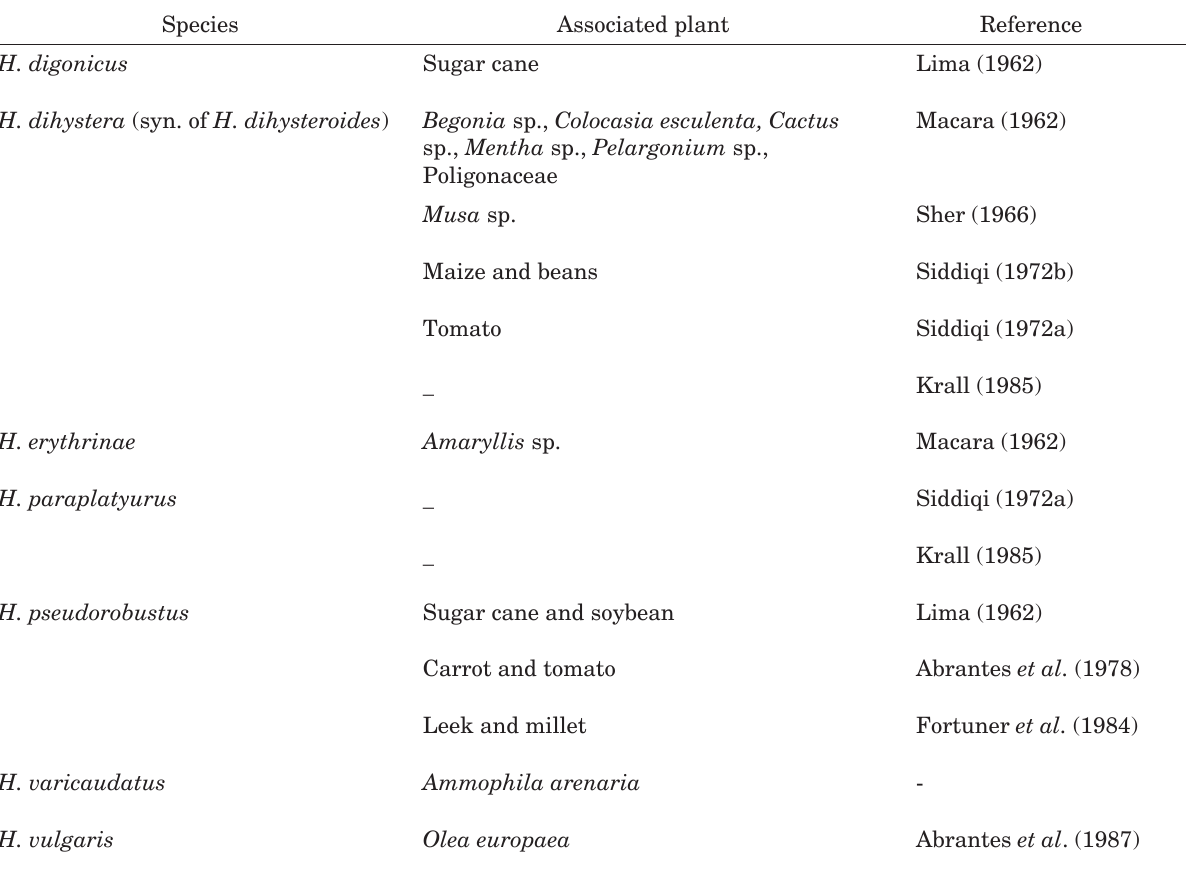
Table 1. Helicotylenchus species identified in